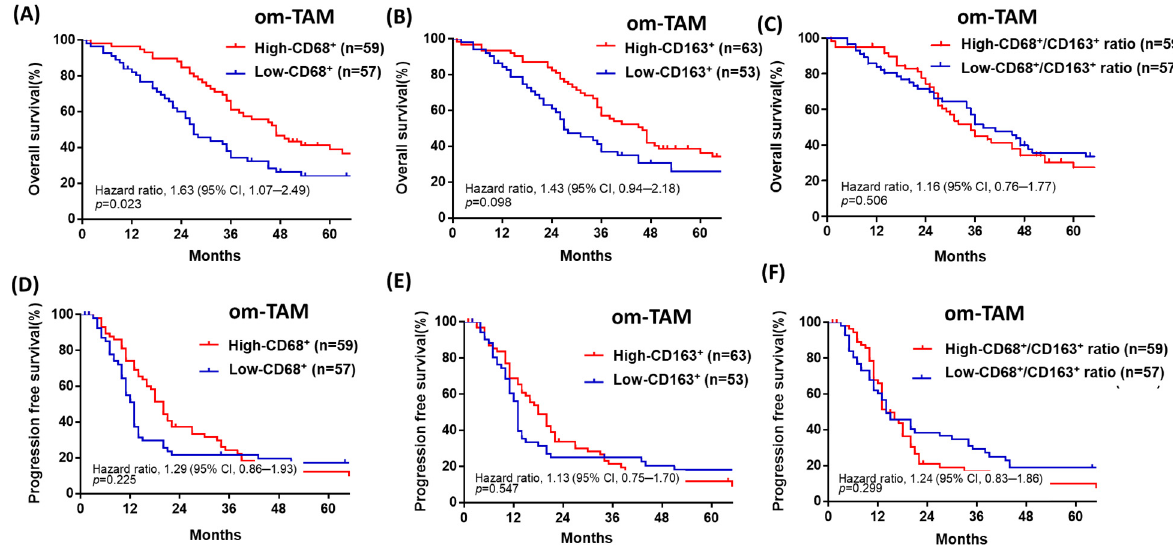
Figure 3. Patients with advanced-stage HGSOC with a low density of omental CD68 + or CD163 + om-TAMs had a poor prognosis in terms of OS. ( A , B ) Patients with a low density of omental CD68 + or CD163 + om-TAMs had poor OS (median survival: 27 vs. 47 months; 26 vs. 46 months, p = 0.023; p = 0.098). ( C , D ) The density of omental CD68 + or CD163 + om-TAMs was not associated with PFS (median survival: 13 vs. 20 months; 13 vs. 18 months, p = 0.225, p = 0.547). ( E , F ) The ratio of omental CD68 + / CD163 + om-TAM was not associated with OS or PFS ( p = 0.50; p = 0.299).